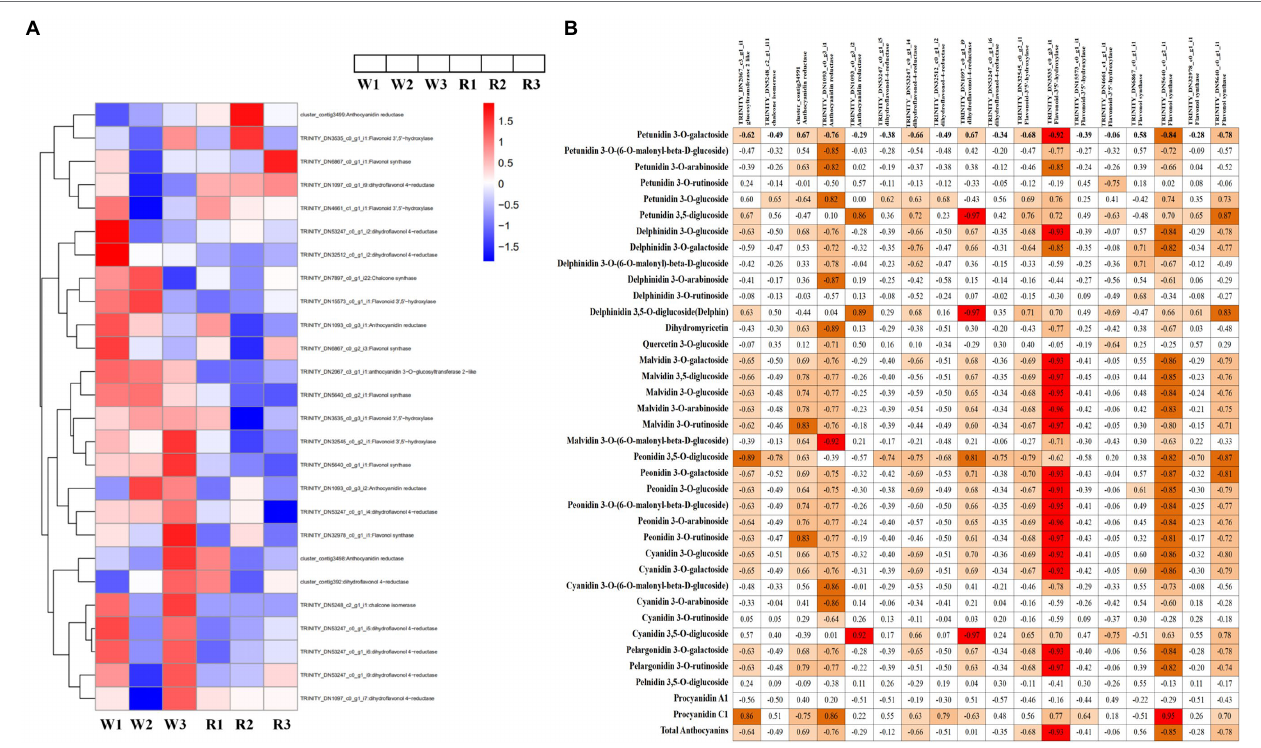
FIGURE 5 | Heatmap of genes encoding key enzymes in the anthocyanin biosynthetic pathway and correlation analysis between anthocyanin content and expression levels of key anthocyanin-biosynthetic genes. (A) Heatmap of structural genes encoding key enzymes in the anthocyanin biosynthetic pathway. Expression level data of different enzyme-coding genes were used in the heatmap analysis. Red indicates higher expression levels and blue indicates lower expression levels. (B) Correlation analysis between anthocyanin content and the expression levels of key anthocyanin-biosynthetic